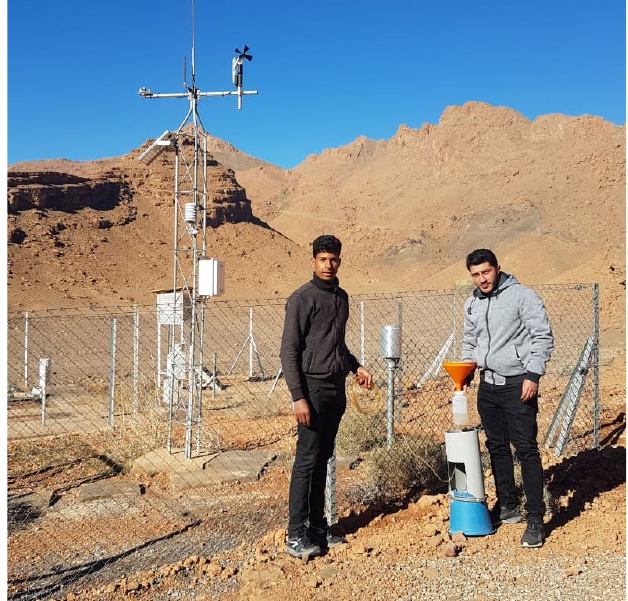
Figure 4. Climatic station.